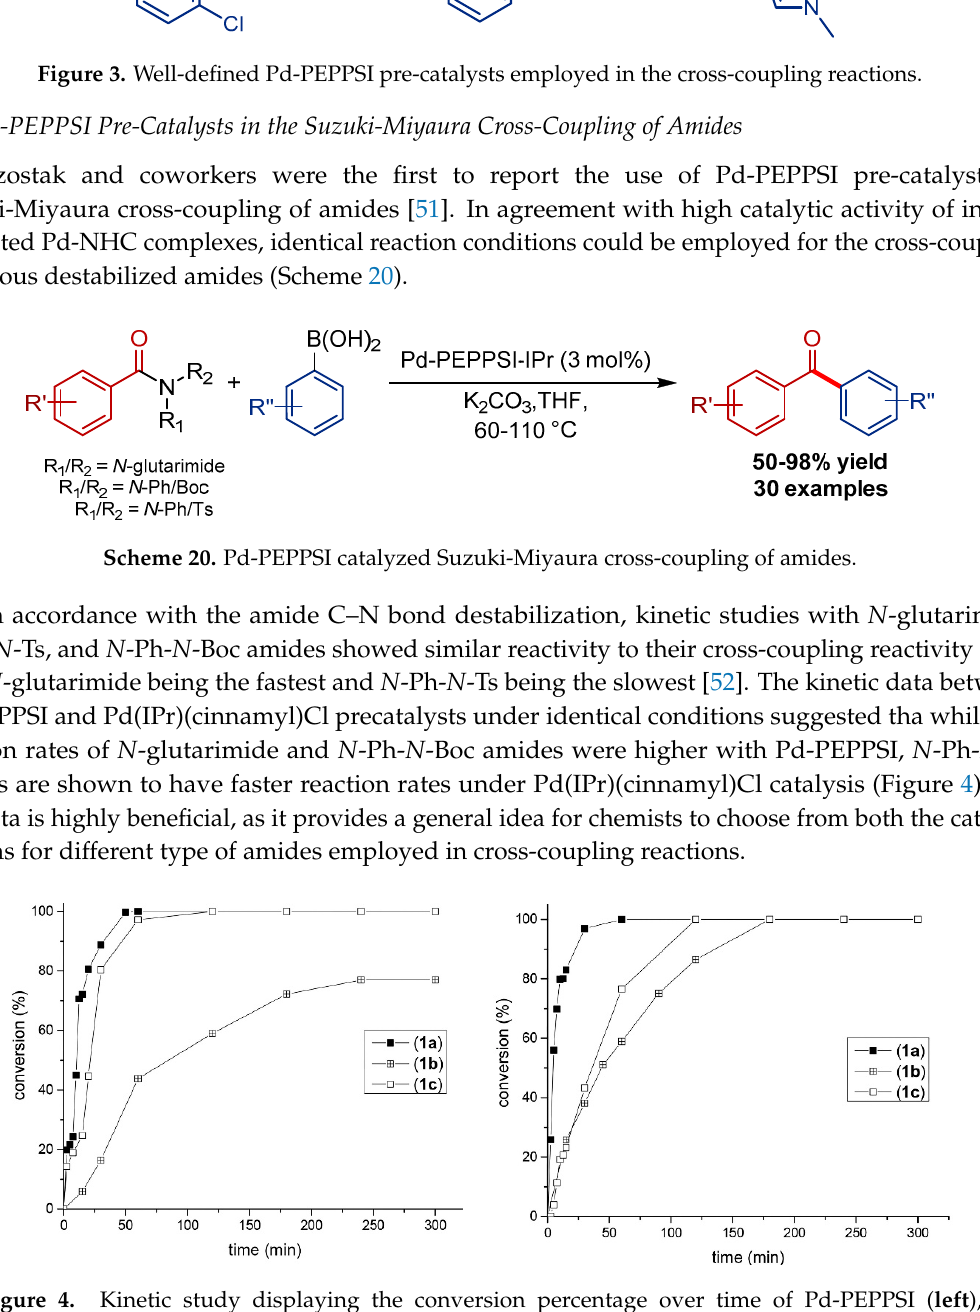
Figure 4. Kinetic study displaying the conversion percentage over time of Pd-PEPPSI ( left ), and Pd(IPr)(Cinnamyl)Cl ( right ) pre-catalysts. Activated amides used were N -Glutarimide ( 1a ), N -Ph- N -Ts ( 1b ), and N -Ph- N -Boc ( 1c ). Reprinted with permission from J. Org. Chem. 2017 , 82 , 6638 − 6646. Copyright 2017 American Chemical